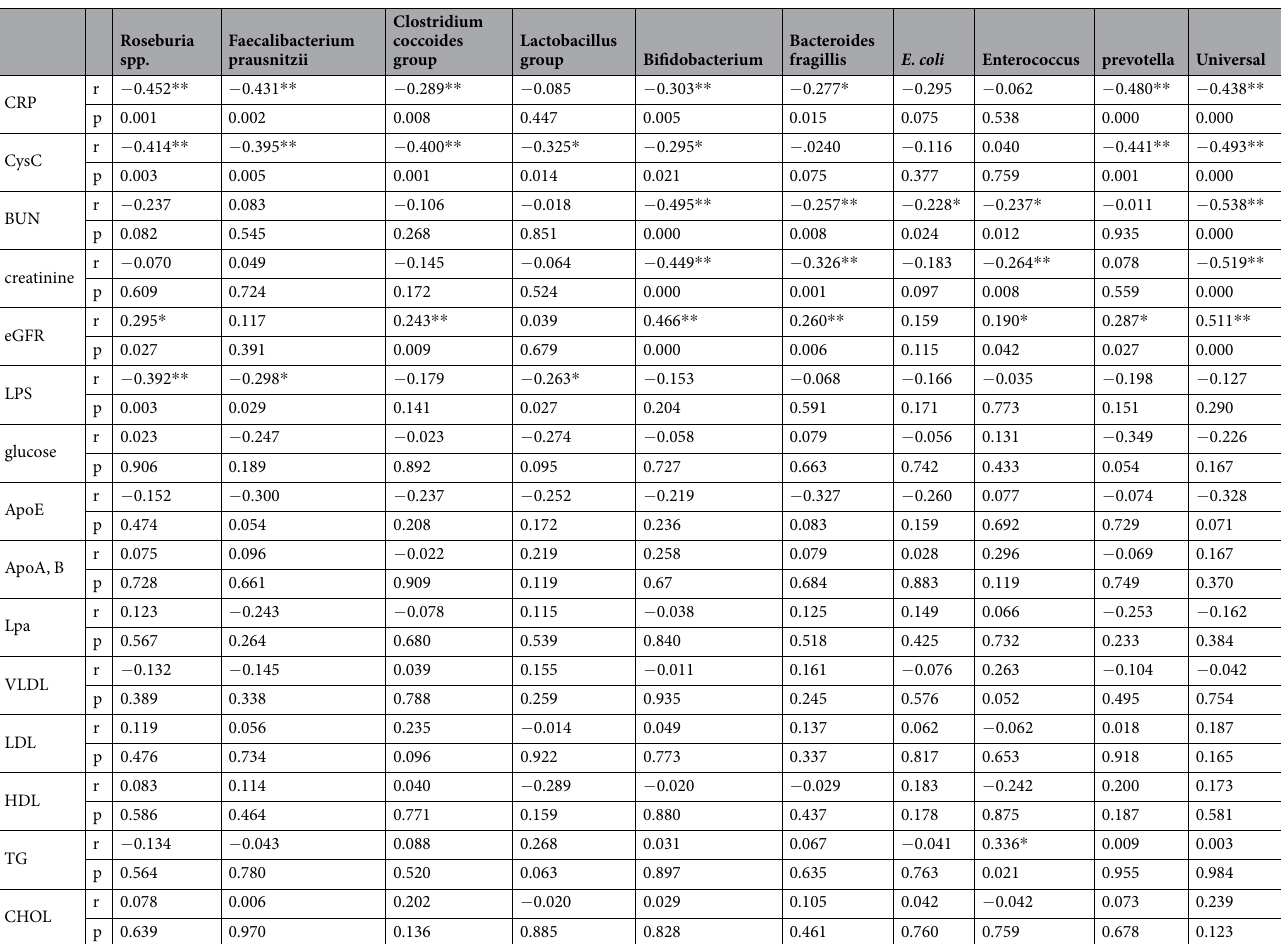
Table 3. Correlation analysis of CRP, CysC, BUN, creatinine, eGFR values and the species count determined by qPCR. Abbrevitions: CysC, Cystatin C; BUN, Blood Urea Nitrogen; eGFR, estimated glomerular filtration rate. Spearman rank correlation were used to evaluate statistical importance: r: correlation coefficient. * p < 0.05, ** p <